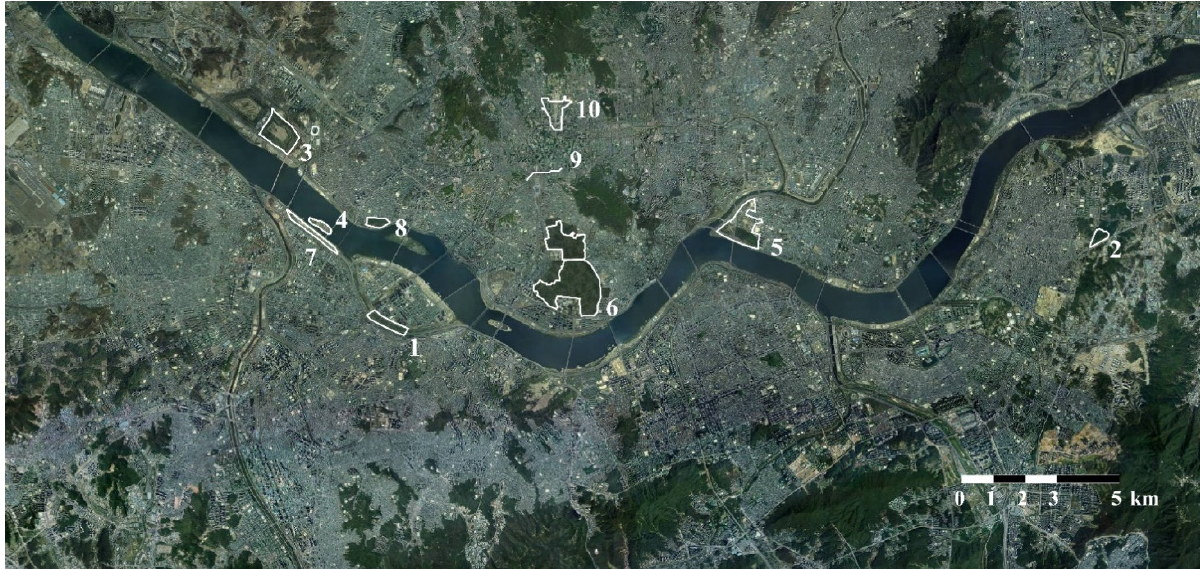
Figure 1. Distribution of case study sites and related conditions in Seoul: (1) Saetgang Ecological Park; (2) Gildong Ecological Park; (3) Haneul Park; (4) Seonyudo Park; (5) Seoul Forest Park; (6) Yongsan Park; (7) Mud Infrastructure; (8) Thermal City; (9) Seoullo; (10) Gwanghwamun Square. Source: Author’s drawing based on a digital map from the National Geographic Information Institute of Korea.